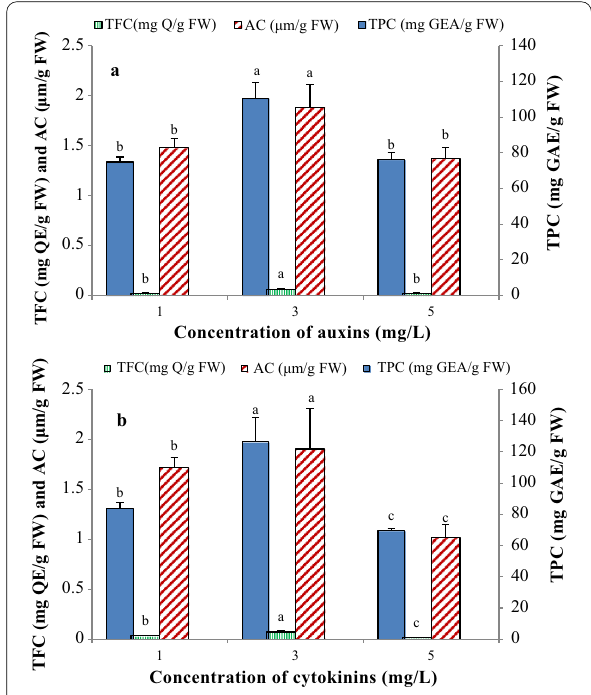
Fig. 6 The effect of auxins ( A ) and cytokinins ( B ) concentration on TPC, TFC and AC content in the callus cultures of M. azedarach L. Bars with different letters indicate a significant difference ( P according to Duncan’s Multiple-Range Tests